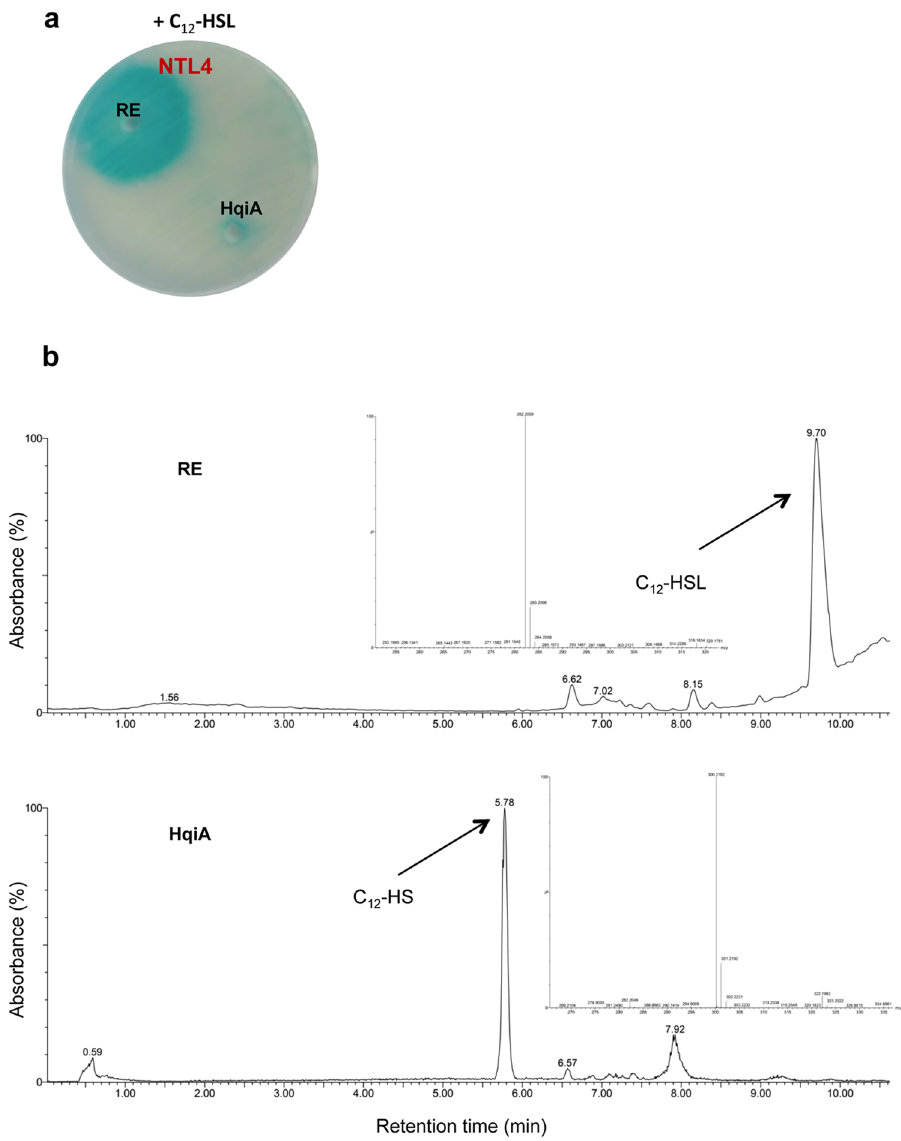
Figure 5. Functional characterization of purified HqiA. ( a ) Detection of the quorum-quenching activity against C 12 -HSL of the purified HqiA protein and the negative control RE (reaction buffer) using the biosensor Agrobacterium tumefaciens NTL4 (pZLR4). ( b ) HPLC/MS analysis of the C 12 -HSL degradation by HqiA. RE and HqiA sample chromatograms are shown. In the RE and HqiA samples, the main peaks masses are 282 and 300 which corresponds to the closed and open-ring form of the C 12 -HSL respectively, therefore indicating a lactonase